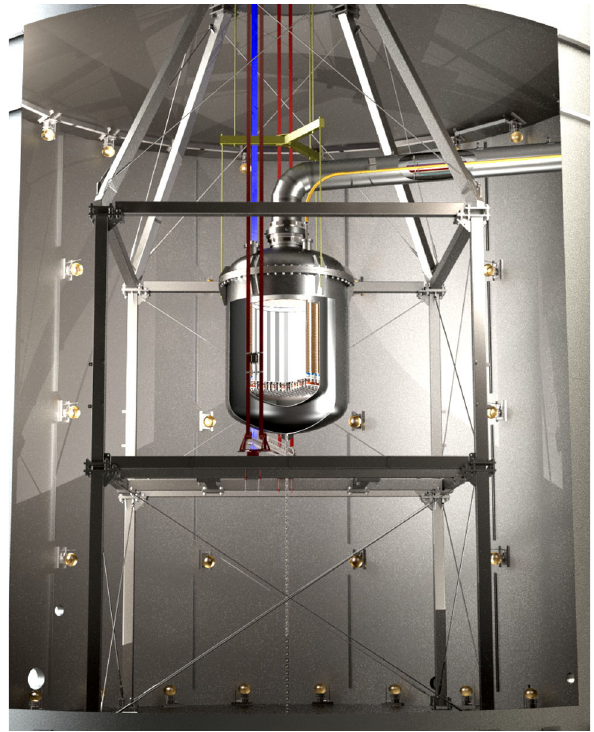
Fig. 6 The stainless-steel cryostat containing the LXe TPC is installed inside a 740m 3 water shield equipped with 84 PMTs deployed on the lateral walls. The cryostat is freely suspended (dark yellow) on a stainless-steel support frame, which can be converted into a cleanroom around the cryostat. The cryostat is connected to the outside by means of two pipes. The large, vacuum-insulated cryogenic pipe carries all gas/LXe pipes and cables. A small pipe (yellow) is used for the cathode high-voltage. Also shown is the system for calibrating XENON1T with externalsourcesinstalledinmovablecollimatorsattachedtobelts(blue,